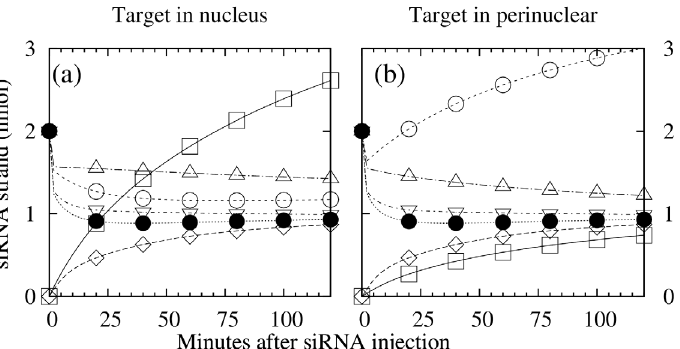
perinuclear region, and rest of cytoplasm, respectively. In all cases p d = 0.4 and s d = 0.6.